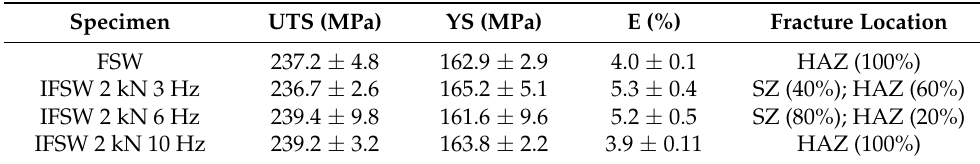
Table 2. Mechanical properties of the studied joints, tensile test.